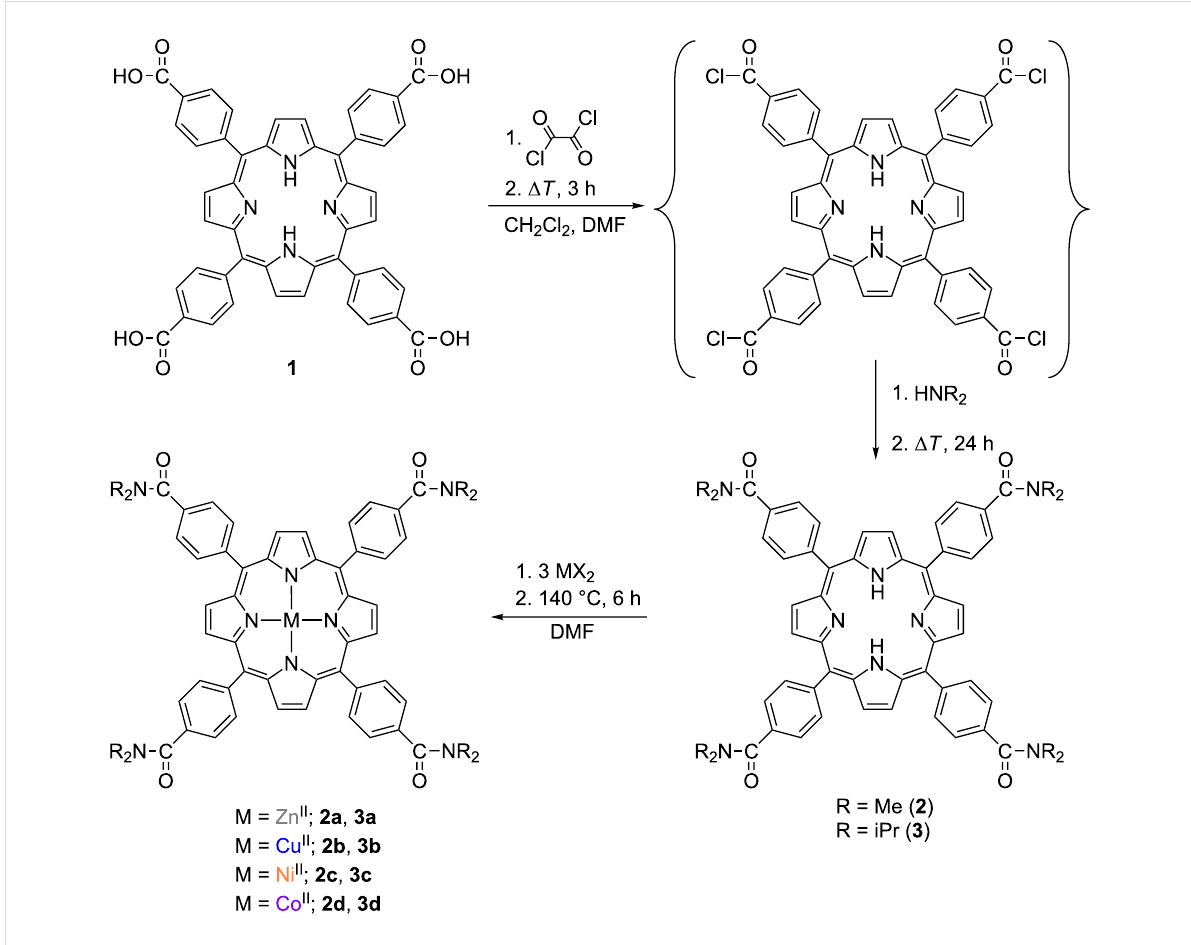
Scheme 1: Synthetic methodology to prepare (metallo)porphyrins 2, 2a–d and 3, 3a–d .